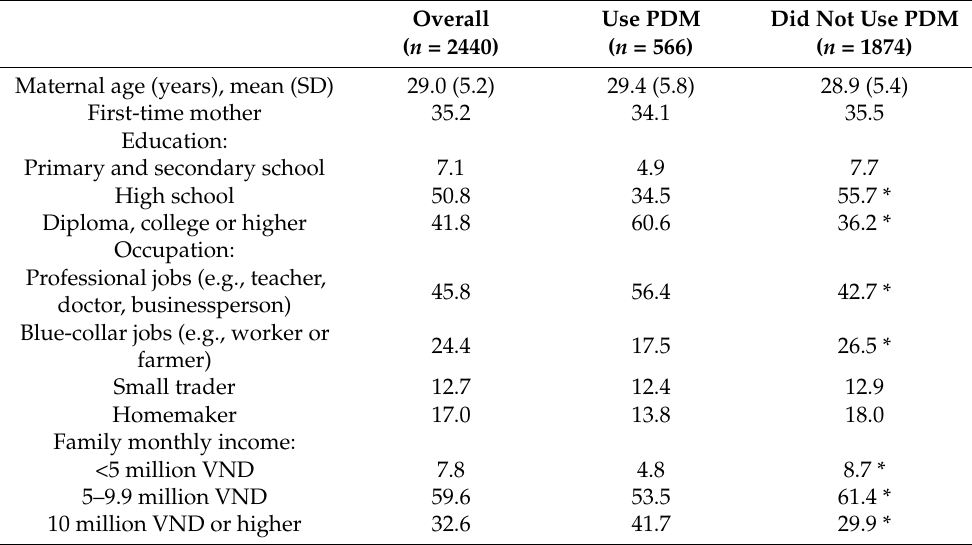
Table 1. Maternal and household characteristics by pasteurized donor milk